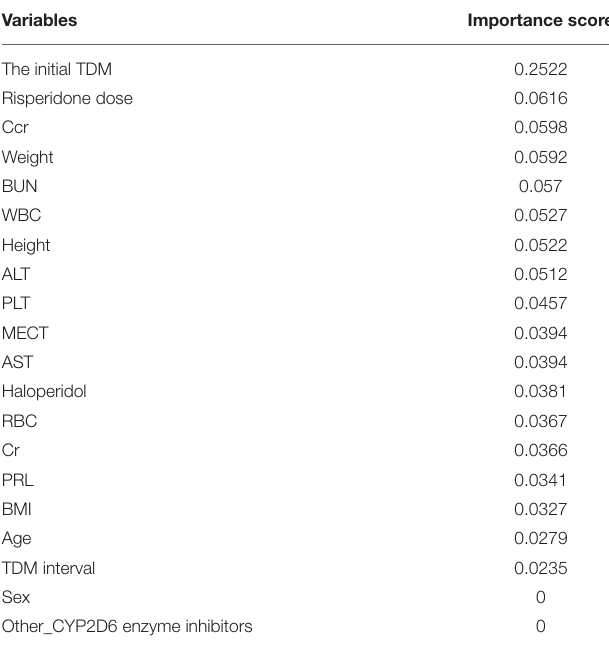
TABLE 2 | Statistical results of univariate analysis. TABLE 3 | The importance score of variables in